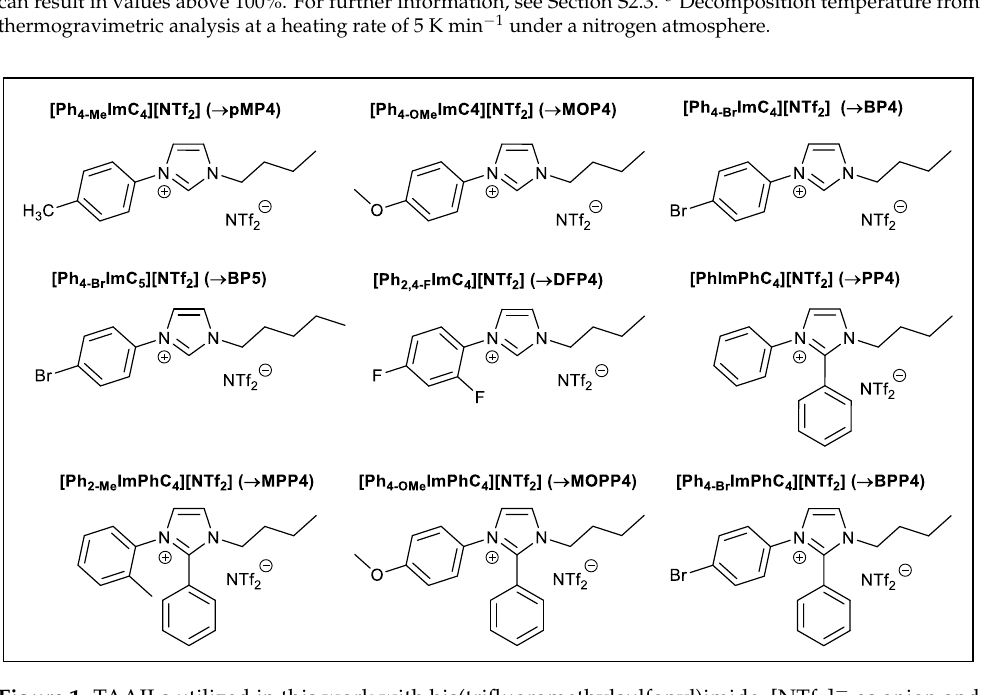
Figure 1. TAAILs utilized in this work with bis(trifluoromethylsulfonyl)imide, [NTf 2 ] − as anion and the sample designation (in parentheses) for the (TAAIL)Pt-NPs.